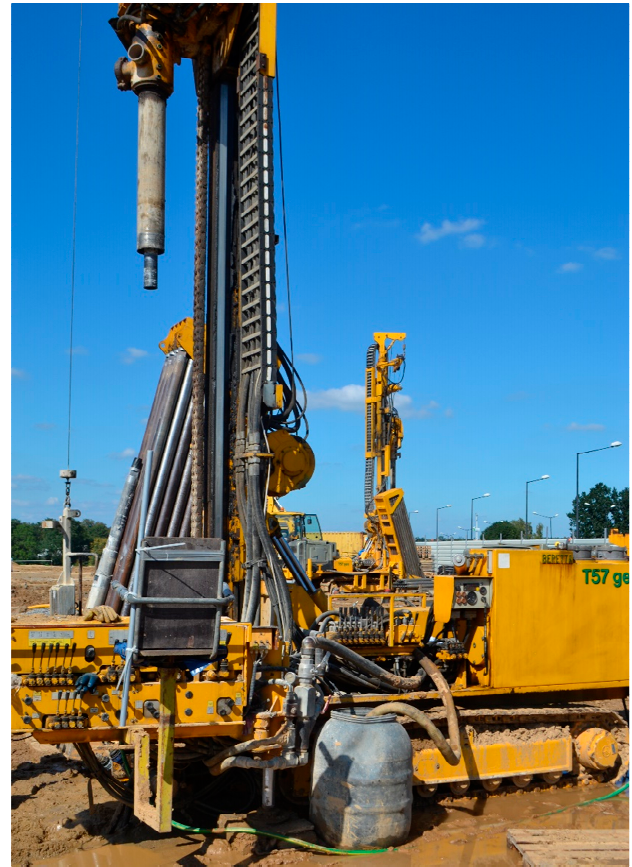
Figure 1. BERETTA T57 geo self-propelled drilling rig (photo by authors).